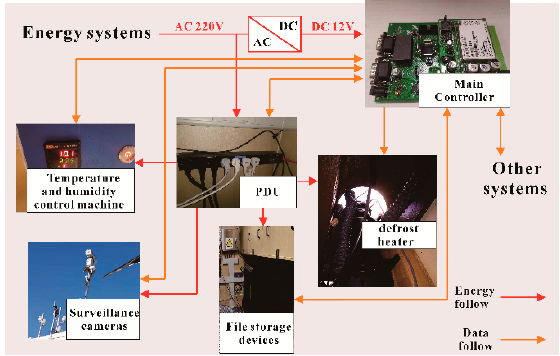
Figure 2. Structure diagram of the environmental protection control system.